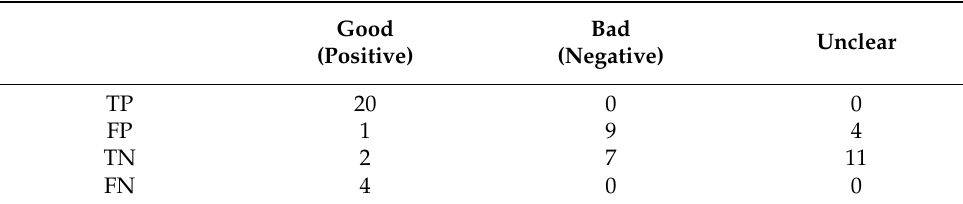
Table 4. Number of ground truth labels given by the clinician compared to the evaluation based on the labels given by the study’s data engineer. Evaluation was done on the worst-performing fold of the nested 10-fold CV procedure. Good